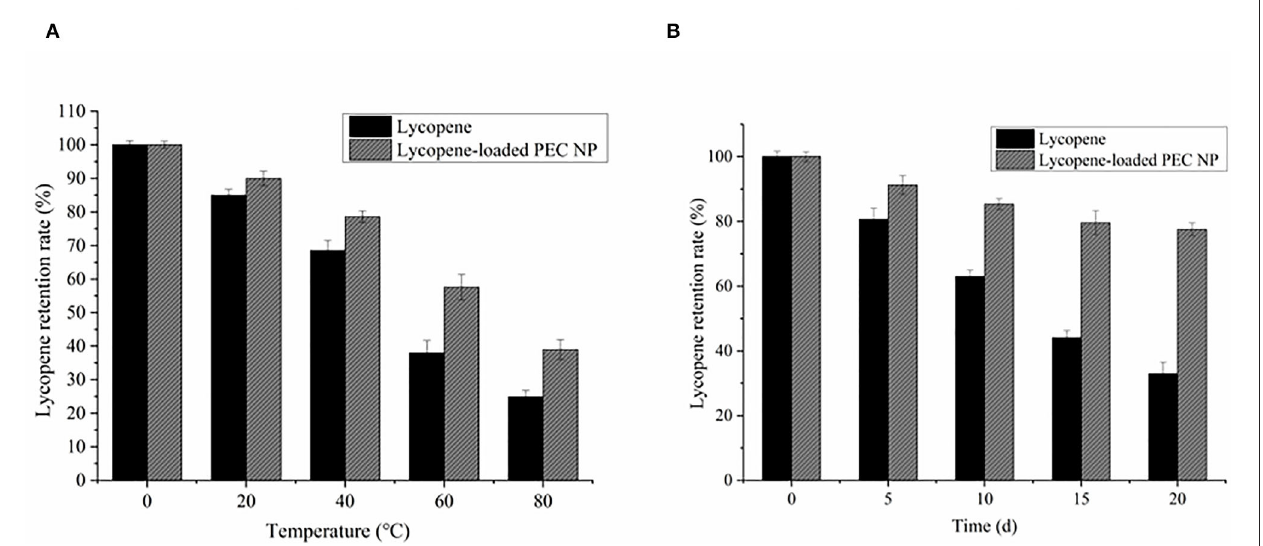
FIGURE 8 | Release of lycopene in lycopene-loaded PEC NPs and free lycopene in SGF and SIF.